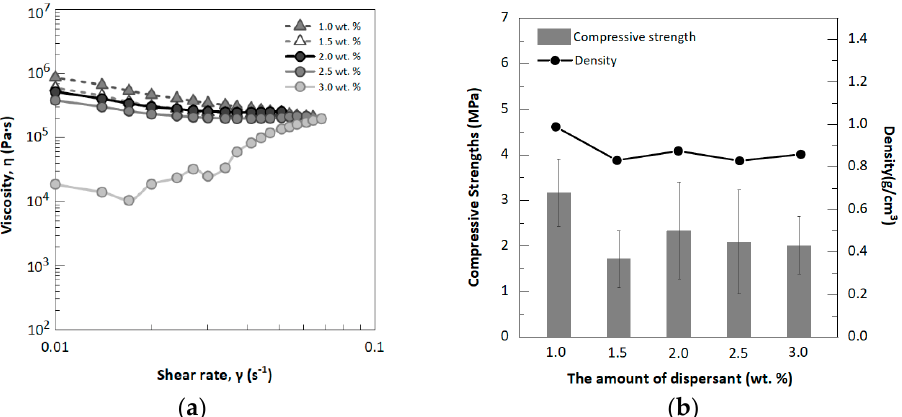
Figure 9. (a) Viscosities of the ZTA slurries with the amount of dispersant, and (b) compressive Figure 9. ( a ) Viscosities of the ZTA slurries with the amount of dispersant, and ( b ) compressive strengths and density levels strengths and density levels of ZTA slurries depending on the amount of dispersant used . of ZTA slurries depending on the amount of dispersant